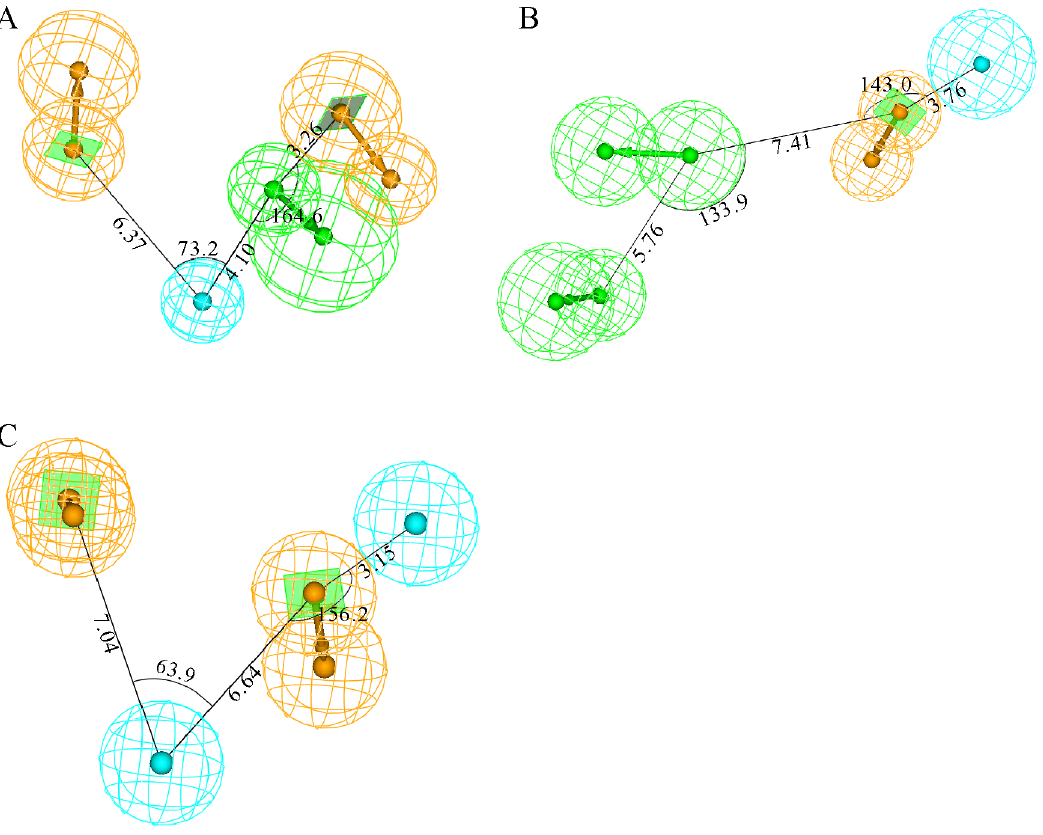
Figure 1. Pharmacophore models in the ensemble. Generated pharmacophore models (A) Hypo A, (B) Hypo B, and (C) Hypo C, consisting of hydrogen-bond acceptor (green), hydrophobic (light blue), and ring aromatic (orange) chemical features. The interfeature distances and angles among features, depicted in white, are measured in A˚ngstroms and degrees, respectively.